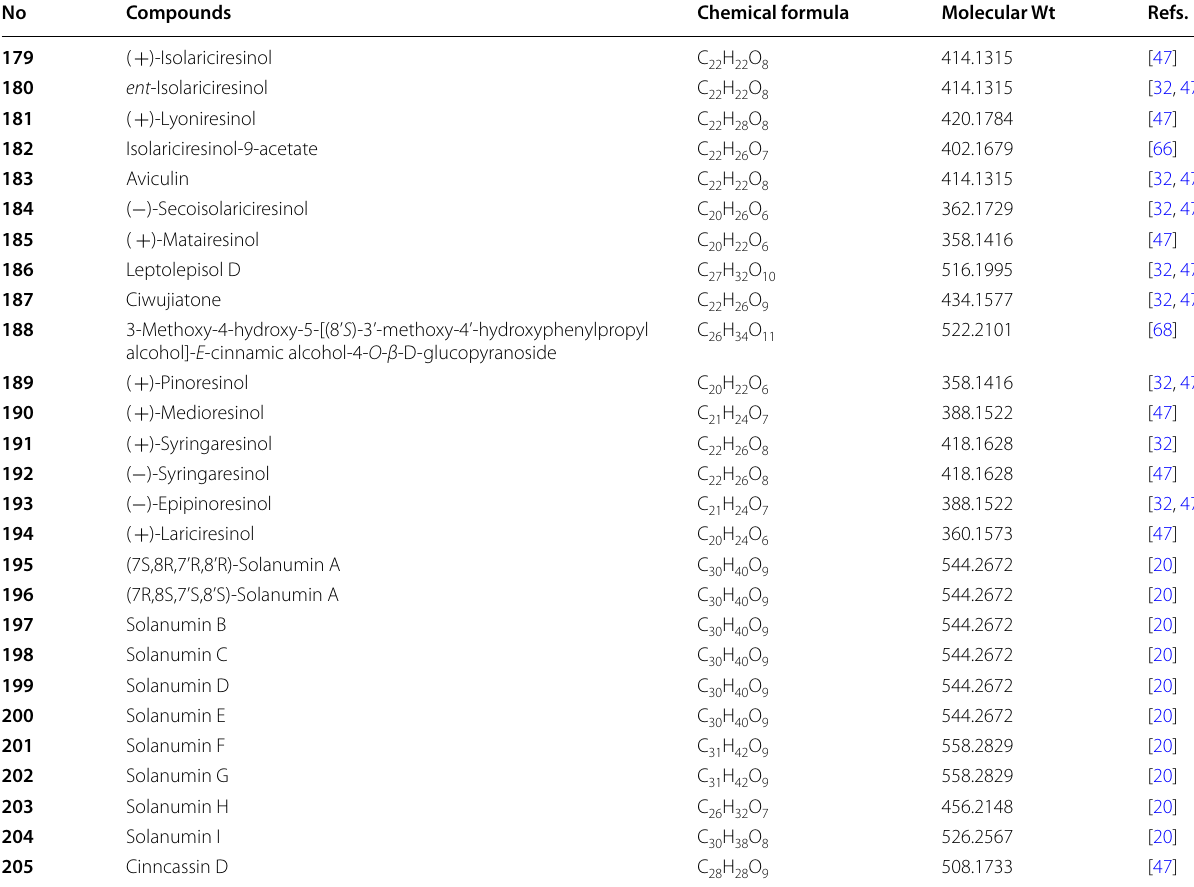
Table 9 Lignans isolated from S.